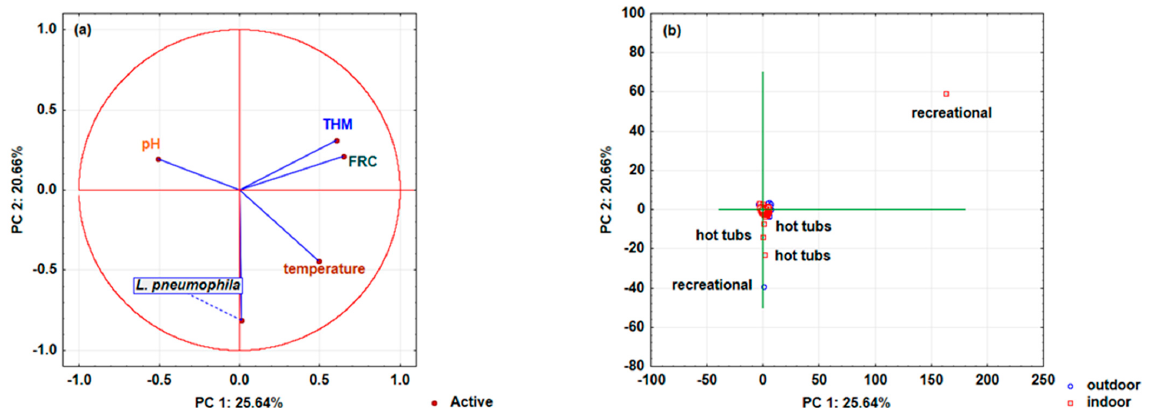
Figure 4. Distribution of analyzed swimming pool water’s physicochemical parameters (temperature ( ◦ C), pH, trihalomethanes (THM; µ g/L), free residual chlorine (FRC; mg/L)), and bacteria: Legionella pneumophila (CFU/L), depending on whether it was an indoor or outdoor swimming pool and the type of swimming pool (children´s, recreational, hot tub, or sports/Olympic), as determined by principal component analysis (PCA) with main components PC 1 and PC 2. Projections of ( a ) the variables (swimming water pools’ physicochemical parameters and bacteria) and ( b ) cases (type of swimming pools and outdoor or indoor conditions) on the factor plane. (N pool data = 4587; N outdoor data = 2233; N indoor data = 2354).